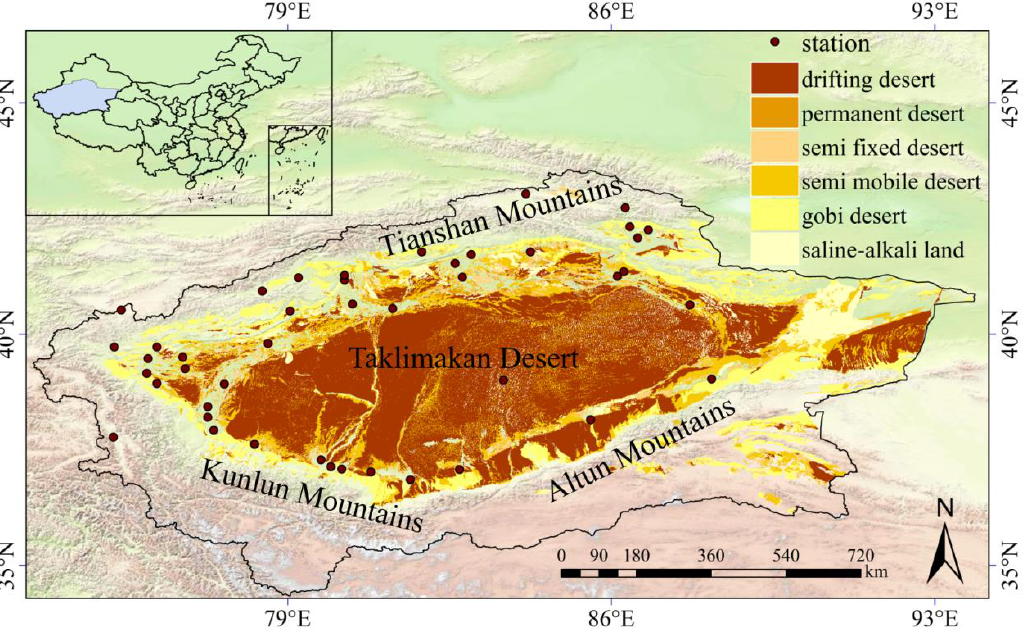
Figure 1. Overview of the study area and distribution of meteorological stations (desert distribution dataset is provided by National Cryosphere Desert Data Center (http://www.ncdc.ac.cn, accessed on 1 June 2022). The standard map No.